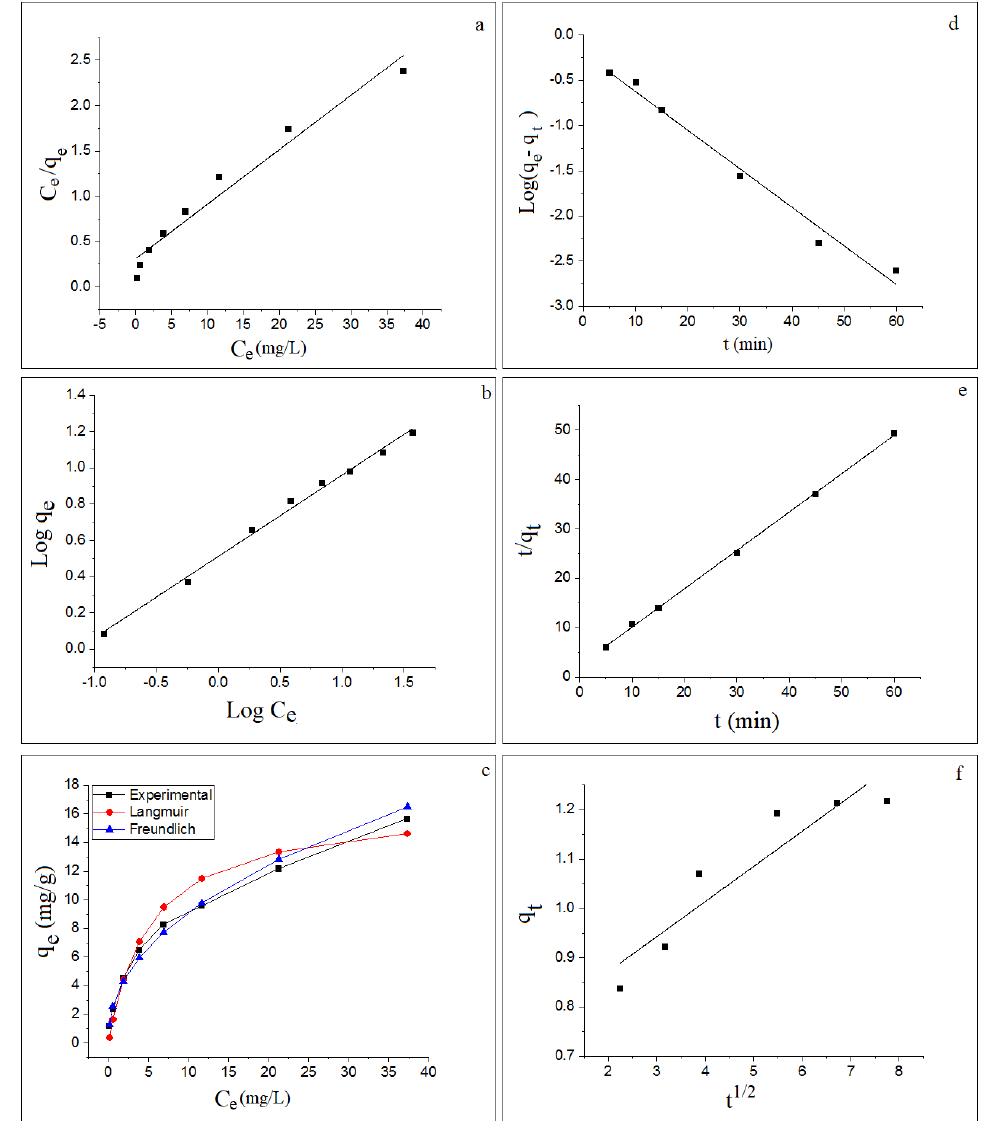
Figure 6. ( a ) Langmuir-adsorption isotherm, ( b ) Freundlich-adsorption isotherm, ( c ) Comparison of isotherms q e vs. C e , ( d ) Pseudo-first-order kinetic model, ( e ) Pseudo-second-order kinetic model and ( f ) Weber – Morris model. Table 1. Adsorption isotherms and Kinetic model — equations and parameters.